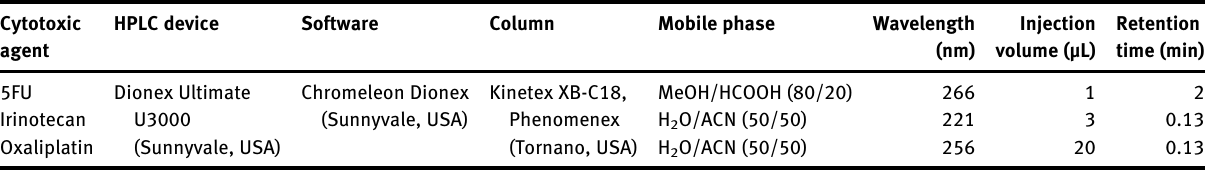
Table  : Description of High Performance Liquid Chromatography method.